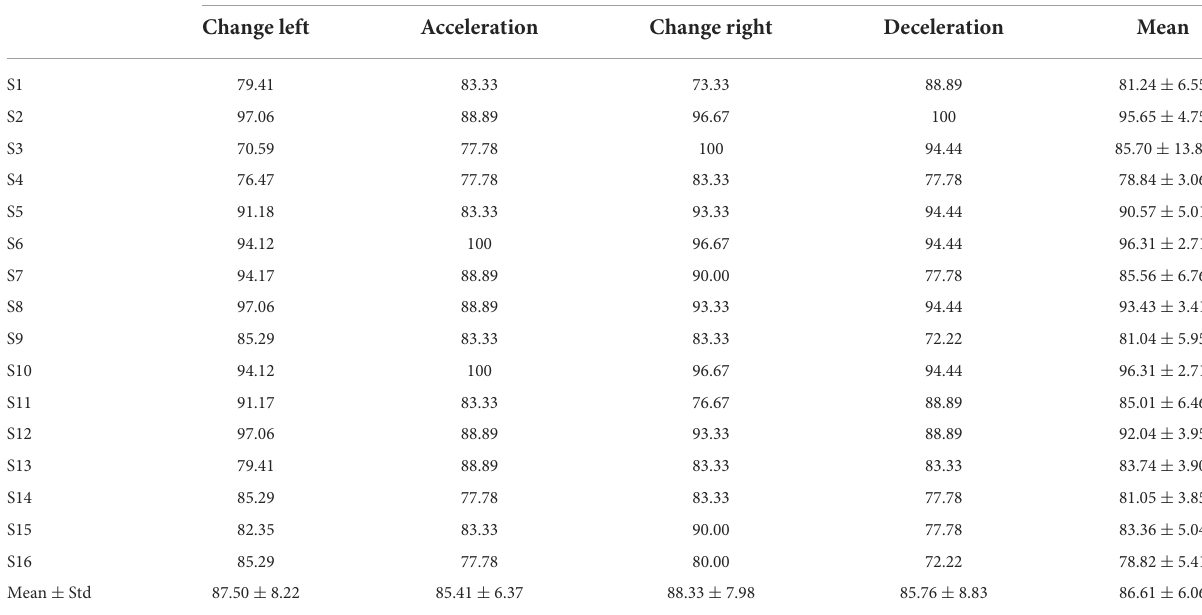
TABLE 4 Averaged accuracies of each subject in the online task. Subjects Acc. (%) Change left Acceleration Change right